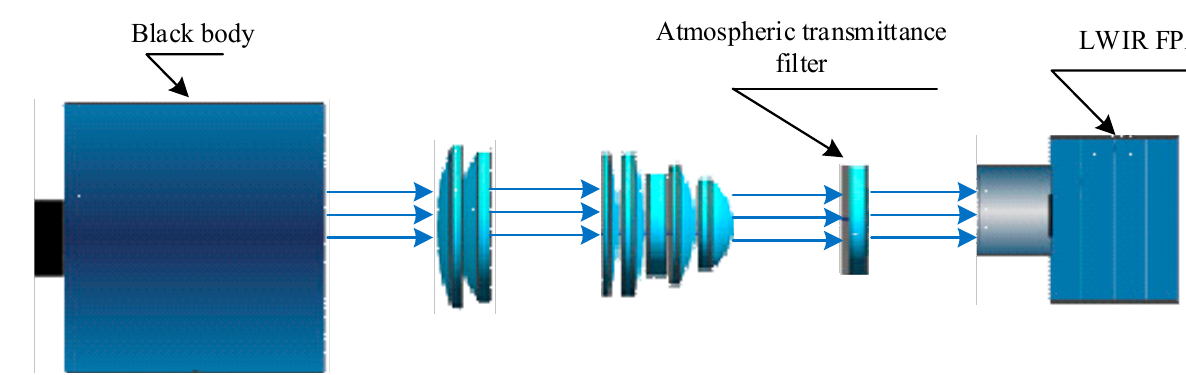
Figure 5. Optical path diagram of the experimental system.